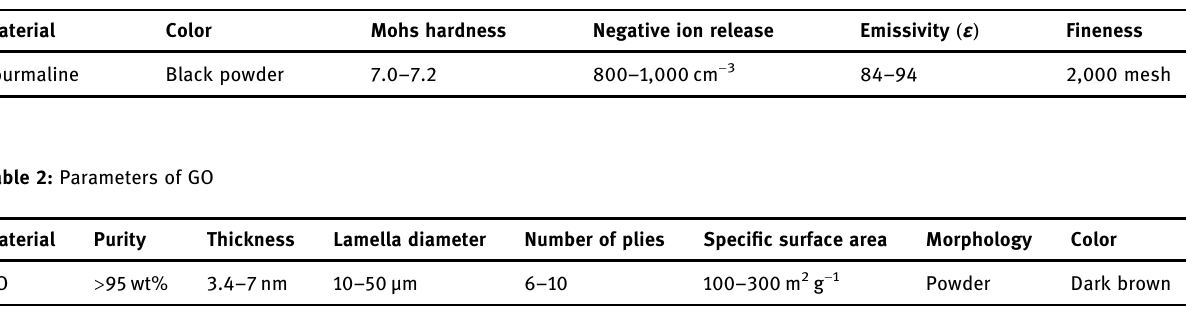
Table 1: Parameters of tourmaline